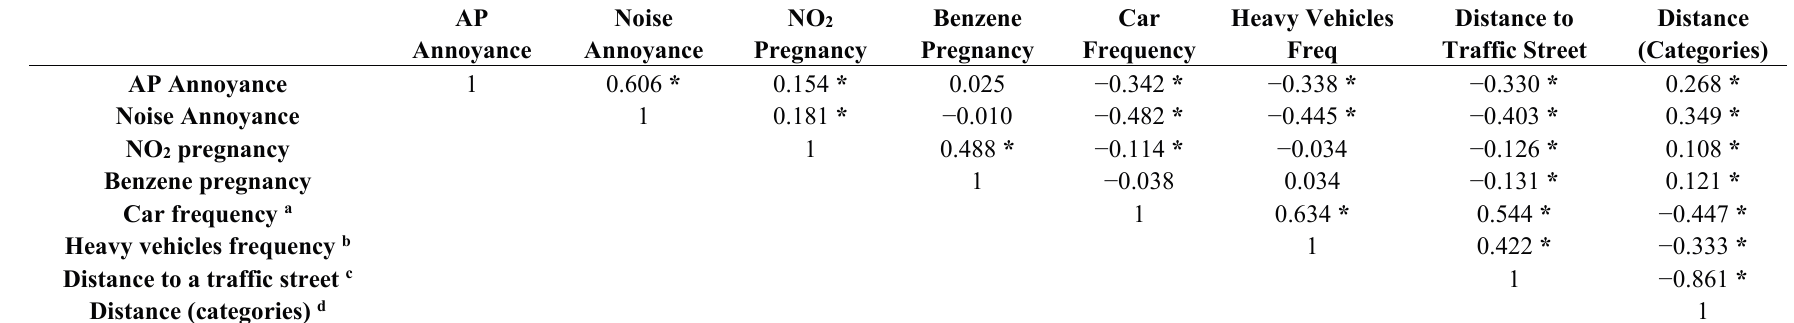
Table 4. Correlations (Spearman’s Rho) between annoyance reports and exposure and traffic related variables.